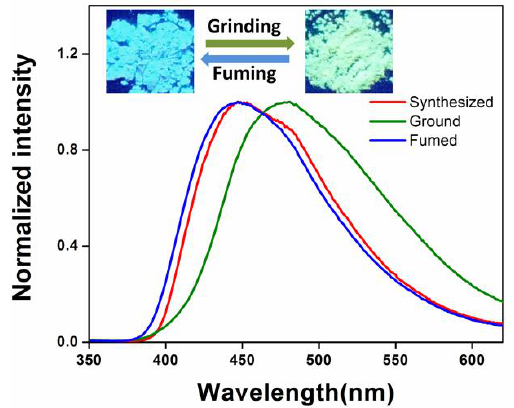
Figure 5. Fluorescence emission spectra of DTITPE as synthesized (red line), after grinding (green line) and after exposure to CH 2 Cl 2 vapor (blue line). Inset: photographs of the ground and CH 2 Cl 2 - fumed solids under UV irradiation (365 nm).